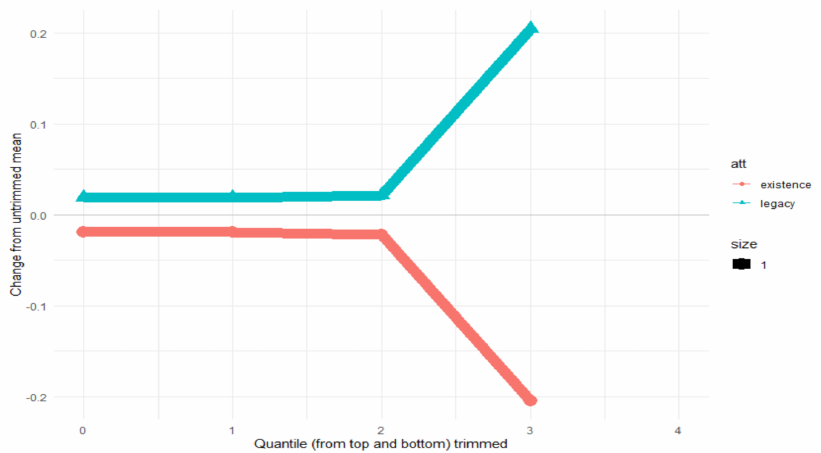
Figure 9. Changes of aggregated weights based on quantile of data trimmed (non-use values).